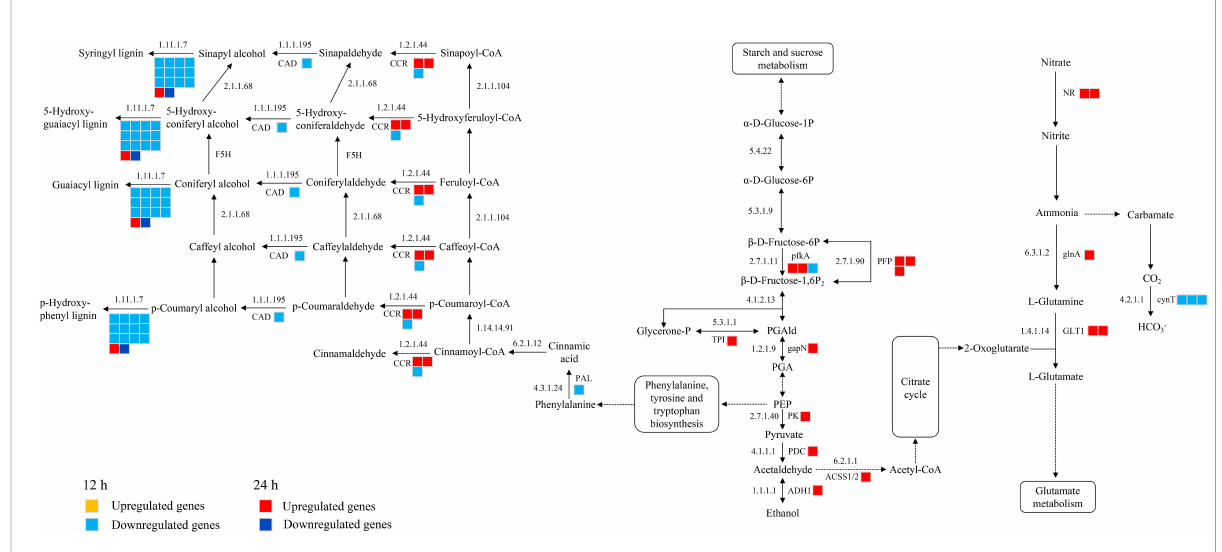
FIGURE 9 Glycolysis, nitrogen metabolism, phenylpropanoid biosynthetic metabolic pathways in histidine treatment atb12 h and 24 h under salt stress. Abbreviations are as follows: NR, nitrate reductase [NADH]; glnA, glutamine synthetase; GLT1, glutamate synthase [NADH]; cynT, carbonic anhydrase; pfkA, 6-phosphofructokinase; PFP, pyrophosphate fructose 6-phosphate 1-phosphotransferase; TPI, triose phosphate isomerase; gapN, glyceraldehyde-3-phosphate dehydrogenase; PK, pyruvate kinase; PDC, pyruvate decarboxylase; ADH1, alcohol dehydrogenase; ACSS1/2, acetyl-coenzyme A synthetase; PAL, phenylalanine ammonia lyase; CCR, cinnamoyl-CoA reductase; CAD, cinnamyl alcohol dehydrogenase; E1.11.1.7, lignin